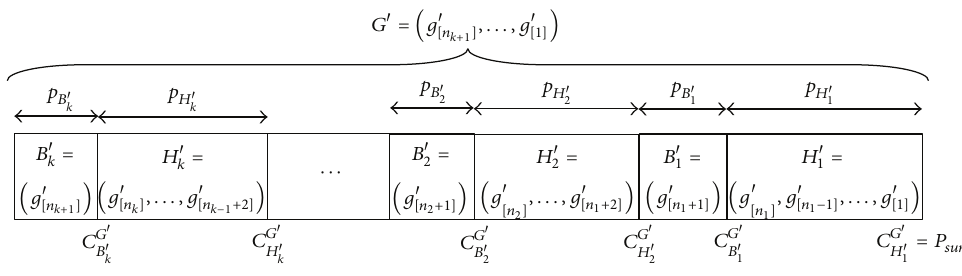
Figure 3: Sequence of tardy jobs in Case 1 before sorting phase.